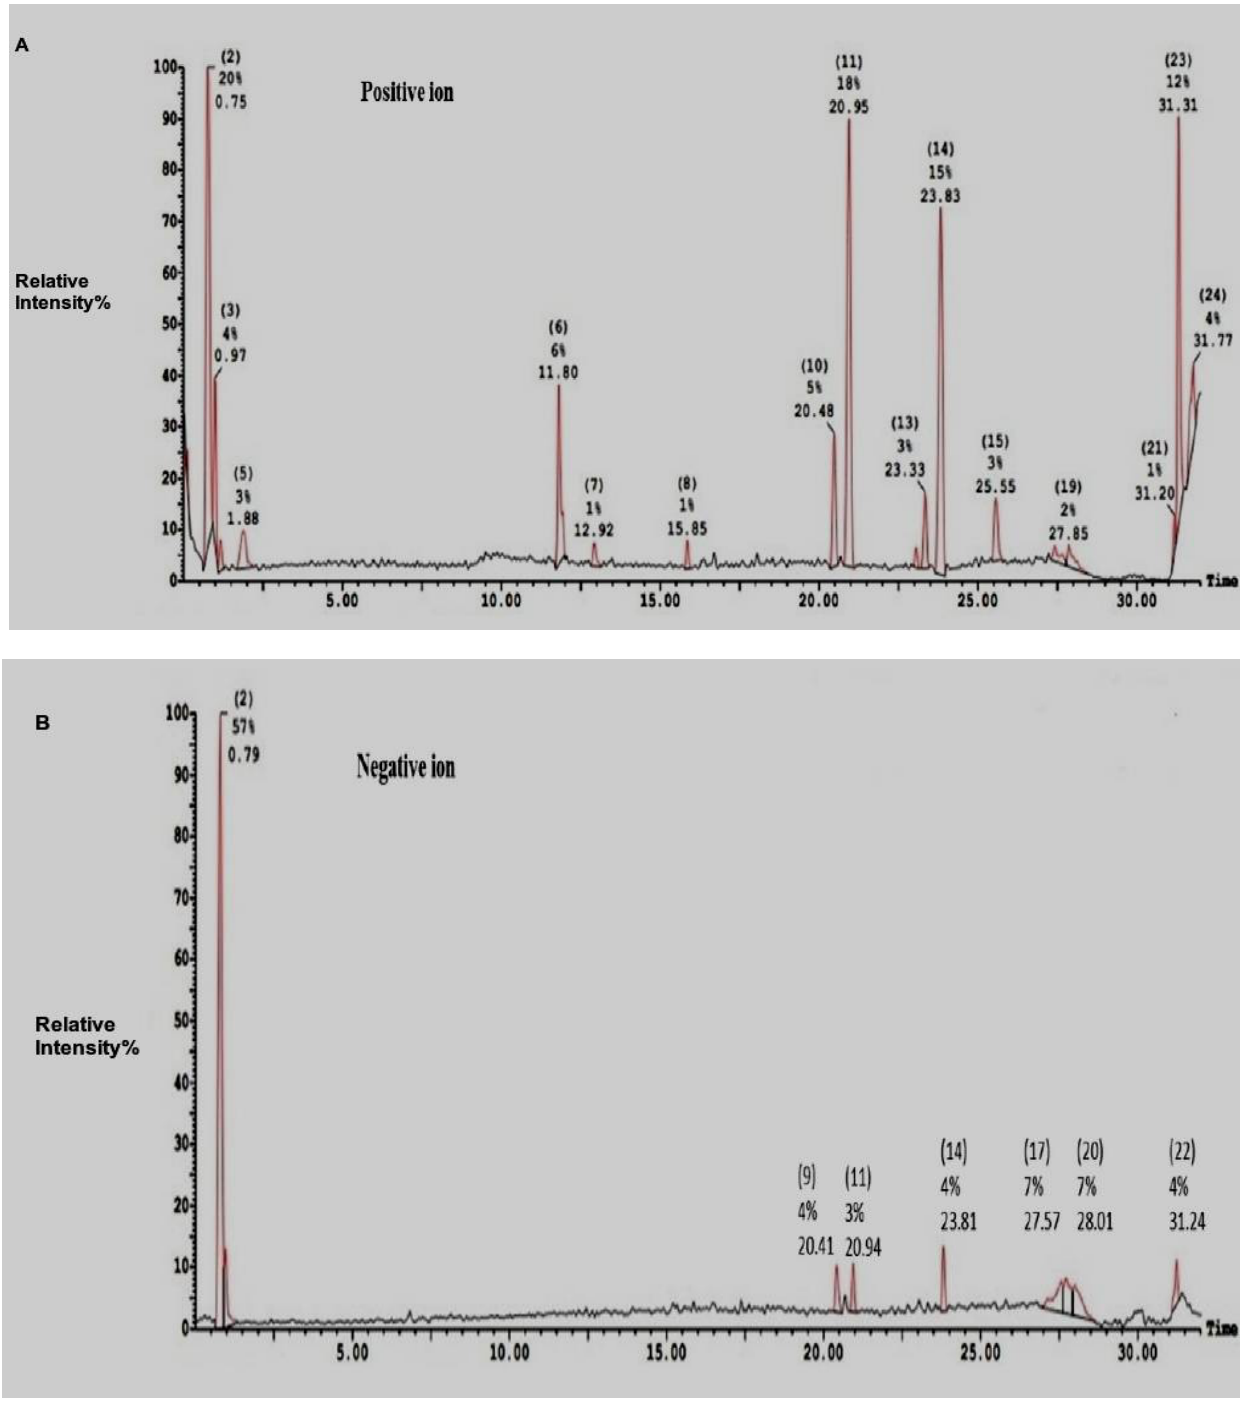
Figure 3. Chromatogram of peptides formation from size exclusion chromatography of fraction 1 showing ( A ): Positive ions portion and ( B ): Negative ions portion.